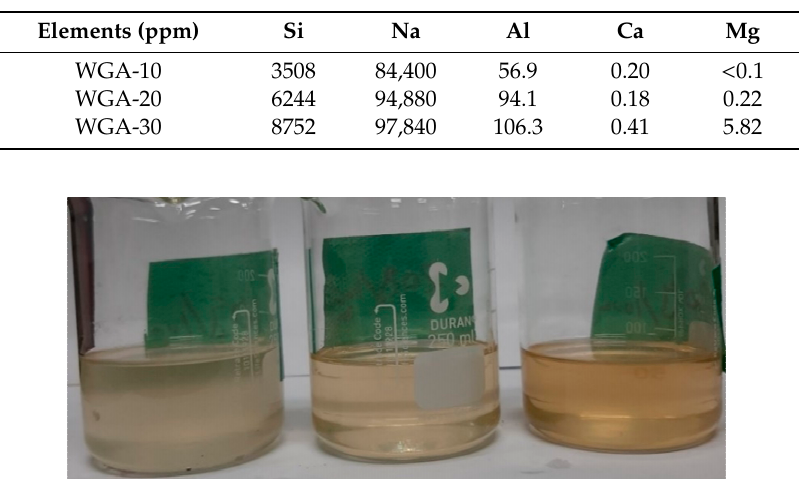
Figure 2. Glass powder-based alkaline solution: WGA-10, WGA-20 and WGA-30.